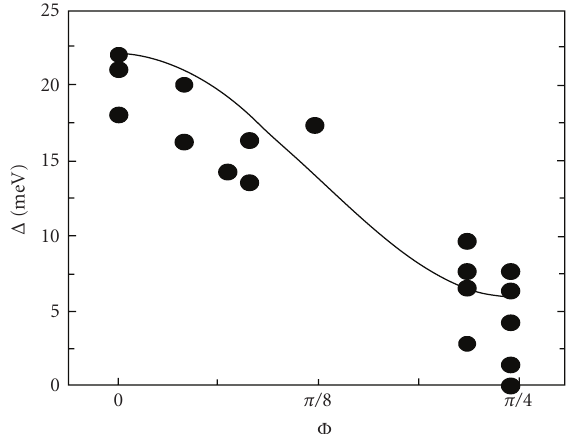
Figure 7: Anisotropic superconducting gap. Exact calculation for Φ = 0 and π /4. This represents an s -wave anisotropic superconducting gap with no nodes in Φ = π /4.